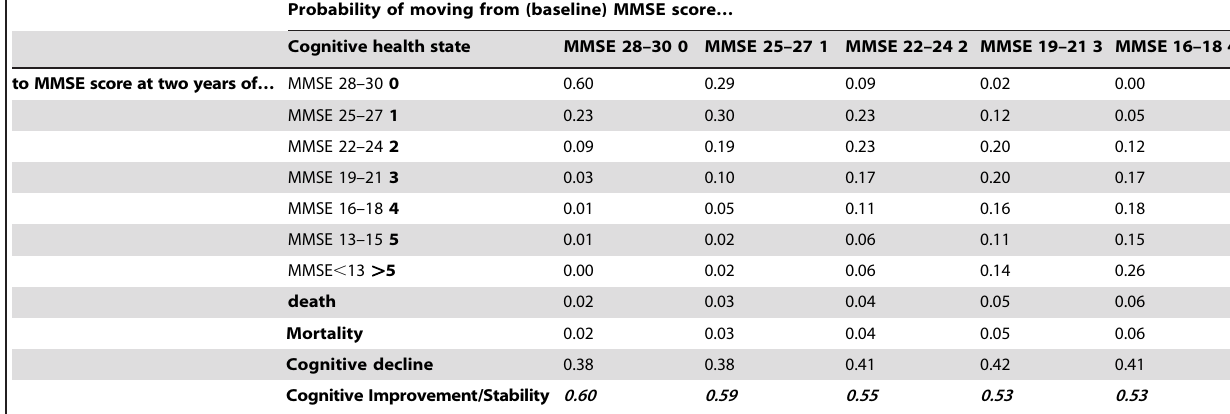
Table 1. Change in MMSE over two years - placebo